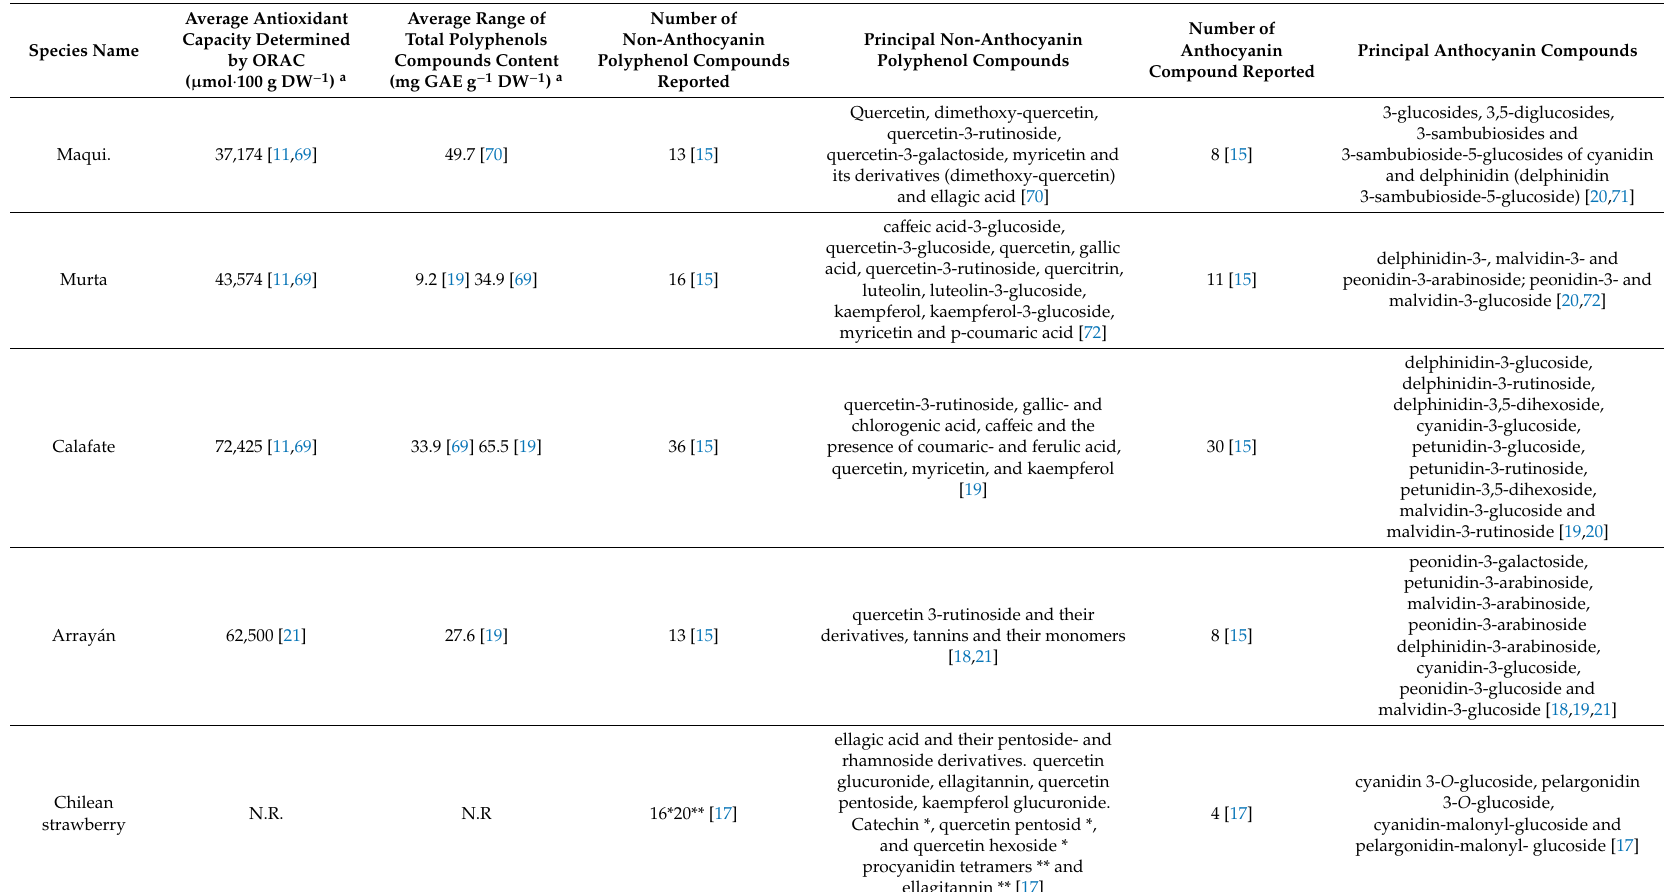
Table 2. Antioxidant information of Patagonian